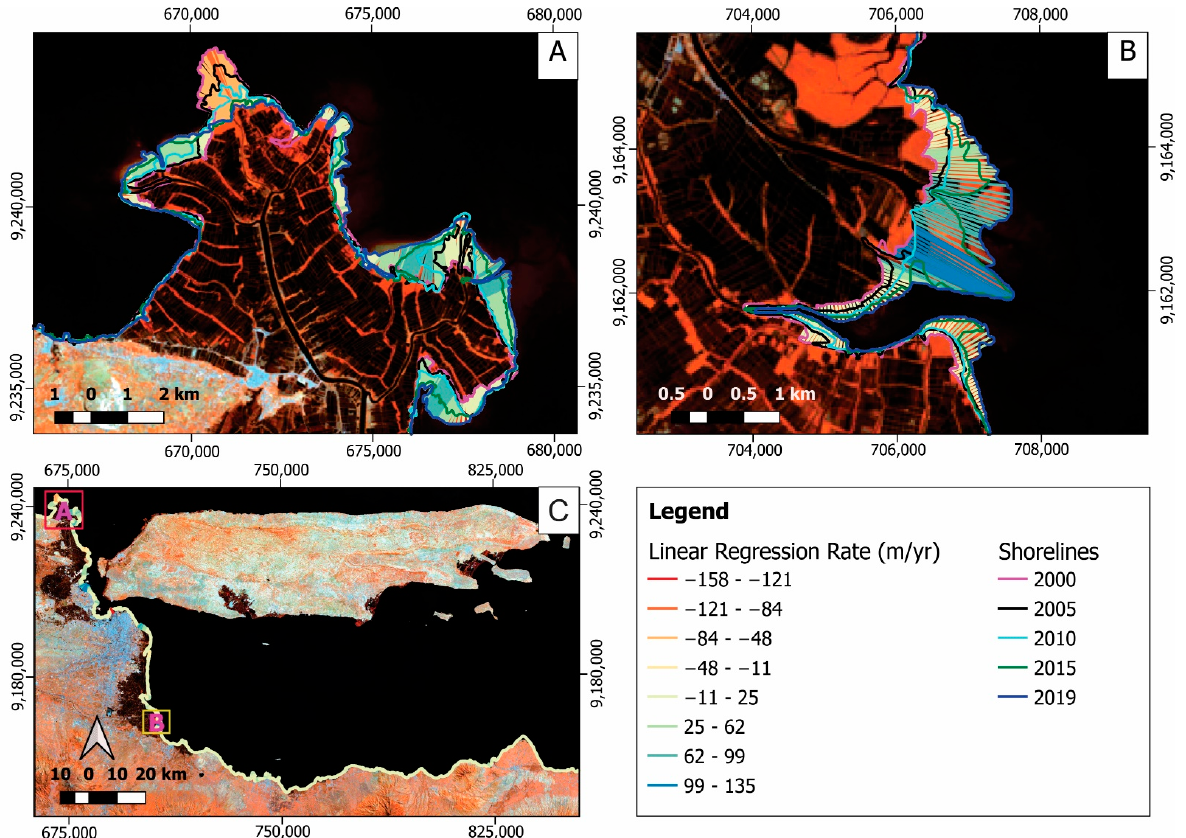
Figure 6. Major shoreline changes in ( A ) the Bengawan Solo delta, which experienced major erosion and accretion, and ( B ) the Brantas/Porong delta, which experienced major accretion, with Inset ( C ) showing the location of both deltas on the shoreline of East Java province.